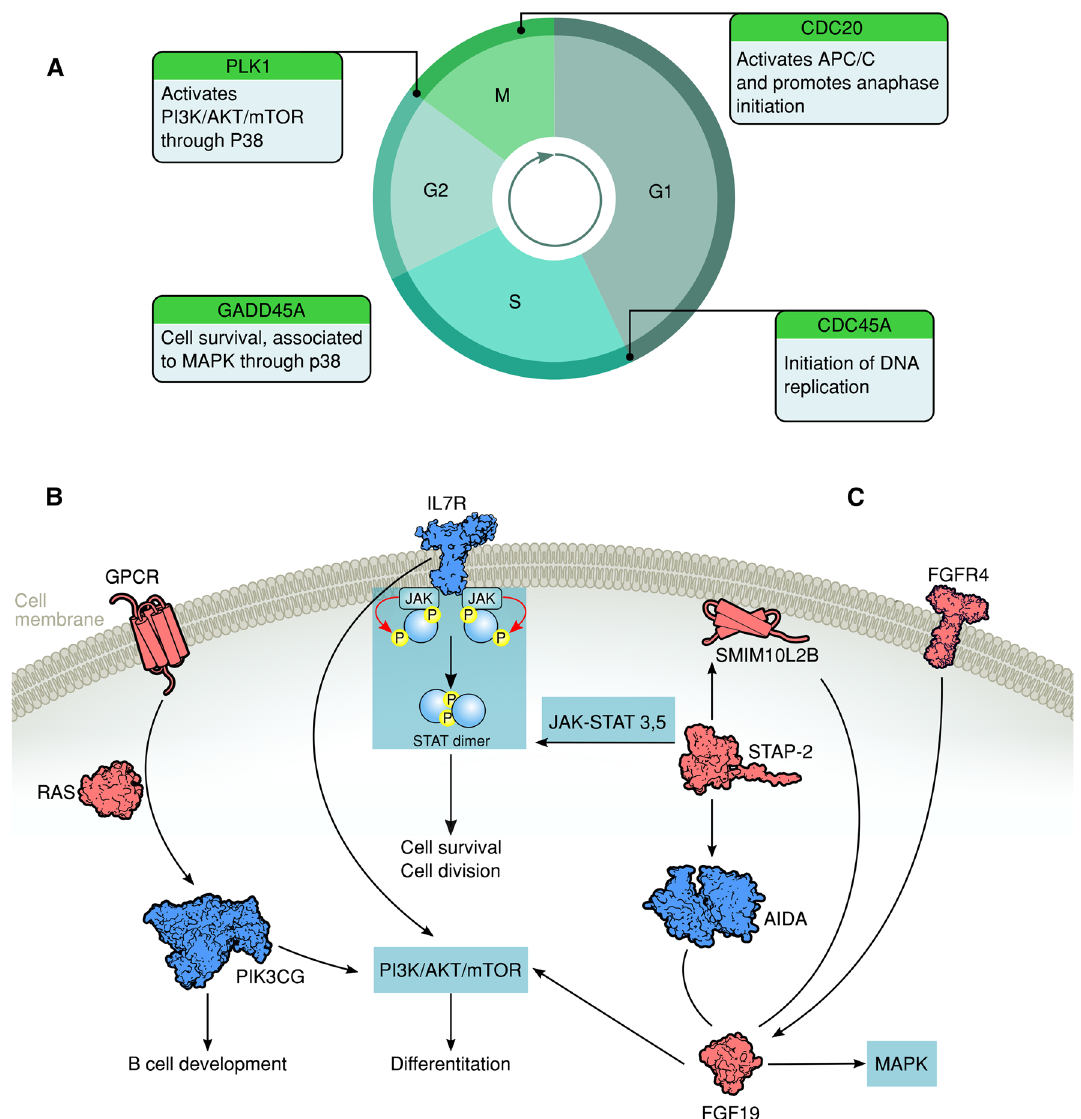
Fig. 4 Gene signatures. A Upregulated cell cycle genes ( PLK1, CDC20, GADD45A , and CDC45) that increase cell proliferation in flow-sorted CD10 + /CD19 + pre-B lymphoblasts from BM, but not from PB samples. B Downregulated genes* (IL7R and PIK3CG) that inhibit differentiation or development in flow-sorted CD10 + /CD19 + pre-B lymphoblasts from BM samples. C ARACNE inferred network for AIDA , a downregulated gene in this study . It is noteworthy that SMIM10L2B is an lncRNA not reported in pre B-ALL before. * In